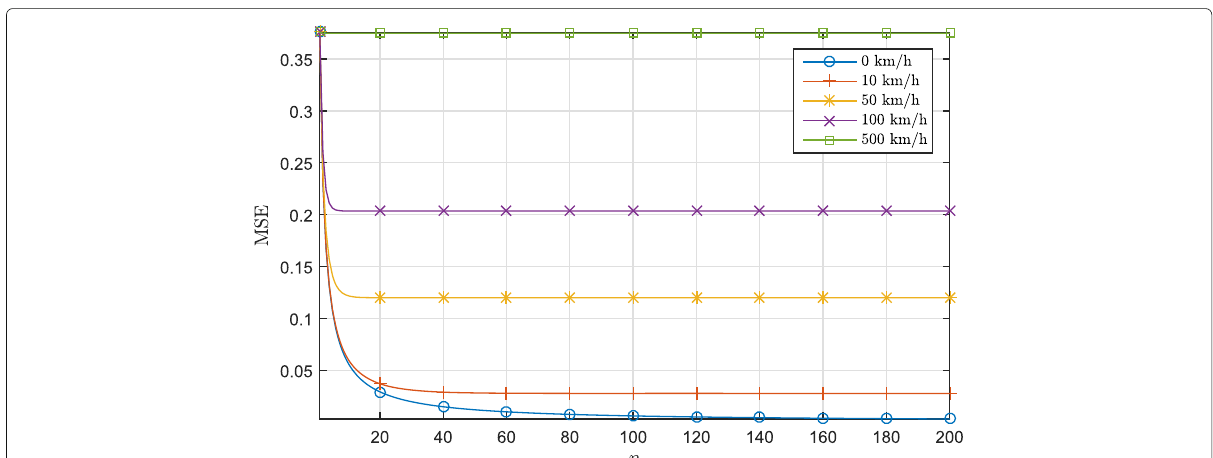
Fig. 6 MSE as a function of the number of pilot signals included in the filter. The results hold for the assumption of a first-order AR model and an optimal